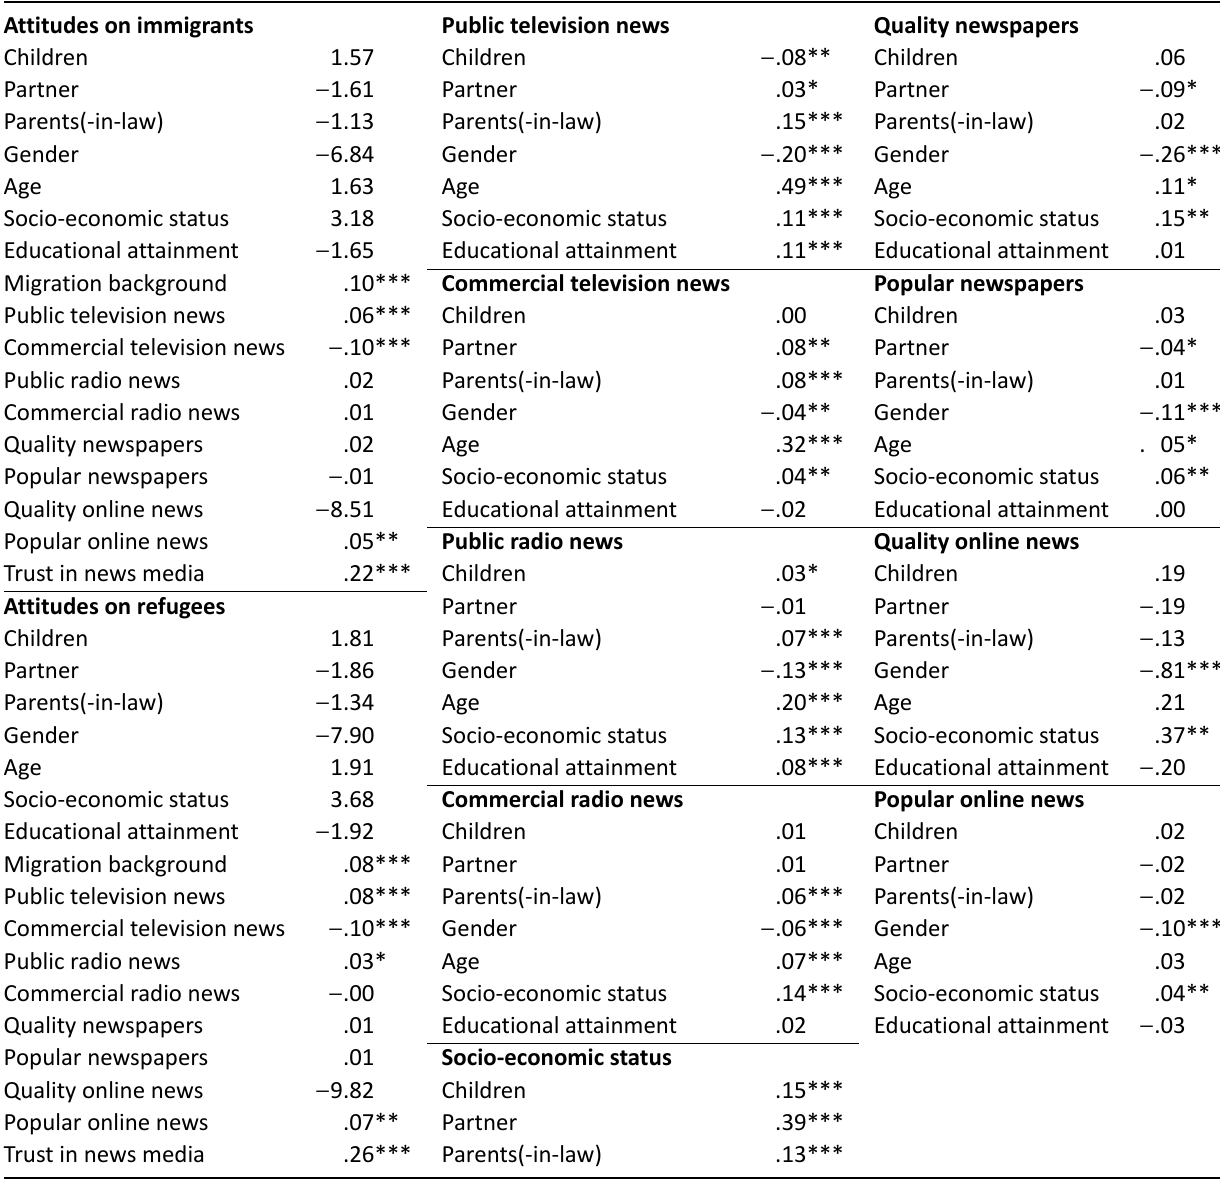
Table 4. Structural equation model of household composition, socio-demographics, media consumption and trust, and immigration and refugee attitudes with standardized